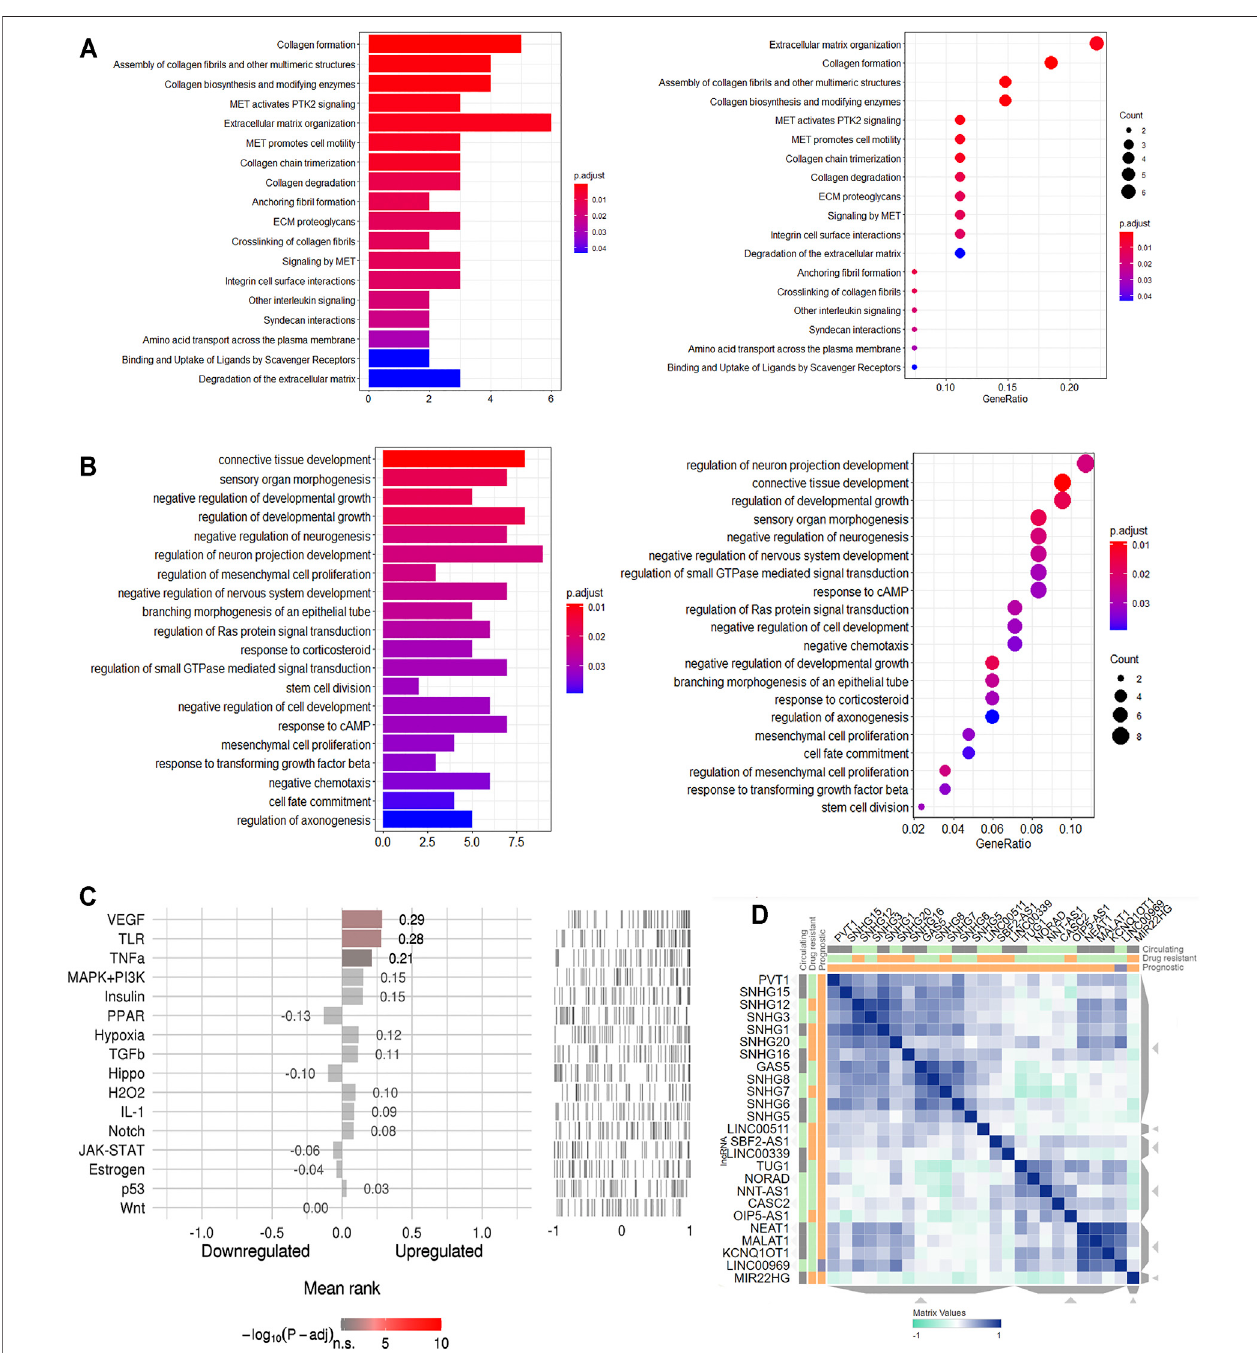
FIGURE 3 | Functional annotation for the genes in ceRNA network of CRC. (A) . Reactome pathway enrichment of the genes in ceRNA network of CRC. (B) . The top 20 enriched molecular in GO terms. (C) . Speed2 pathway activity ranking. (D) . CRC related lncRNAs similarity.